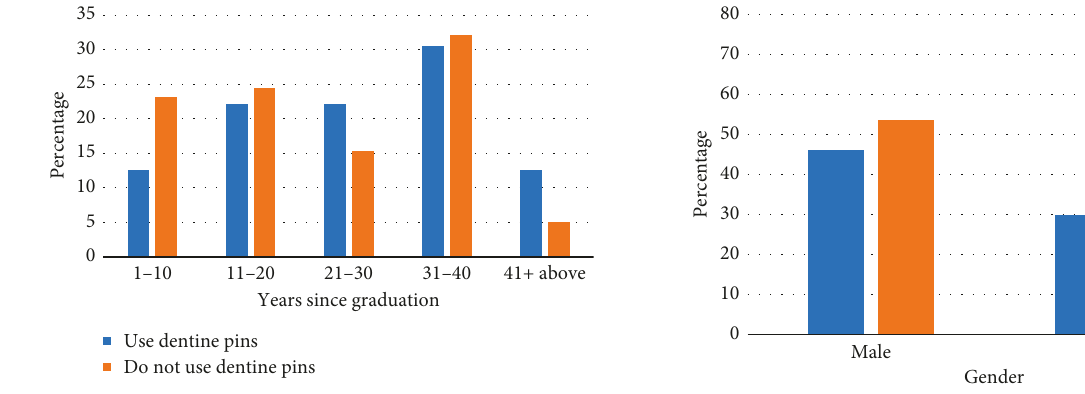
Figure 1: Association between years since graduation and use of dentine pins. Table 2: Type of post systems used by respondents.